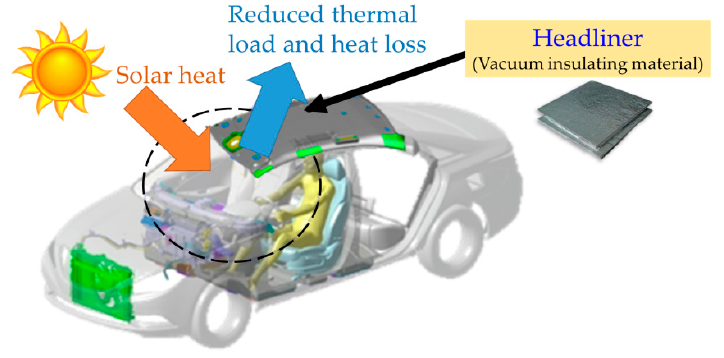
Figure 2. Concept to reduce heat load and heat loss in electric vehicles.